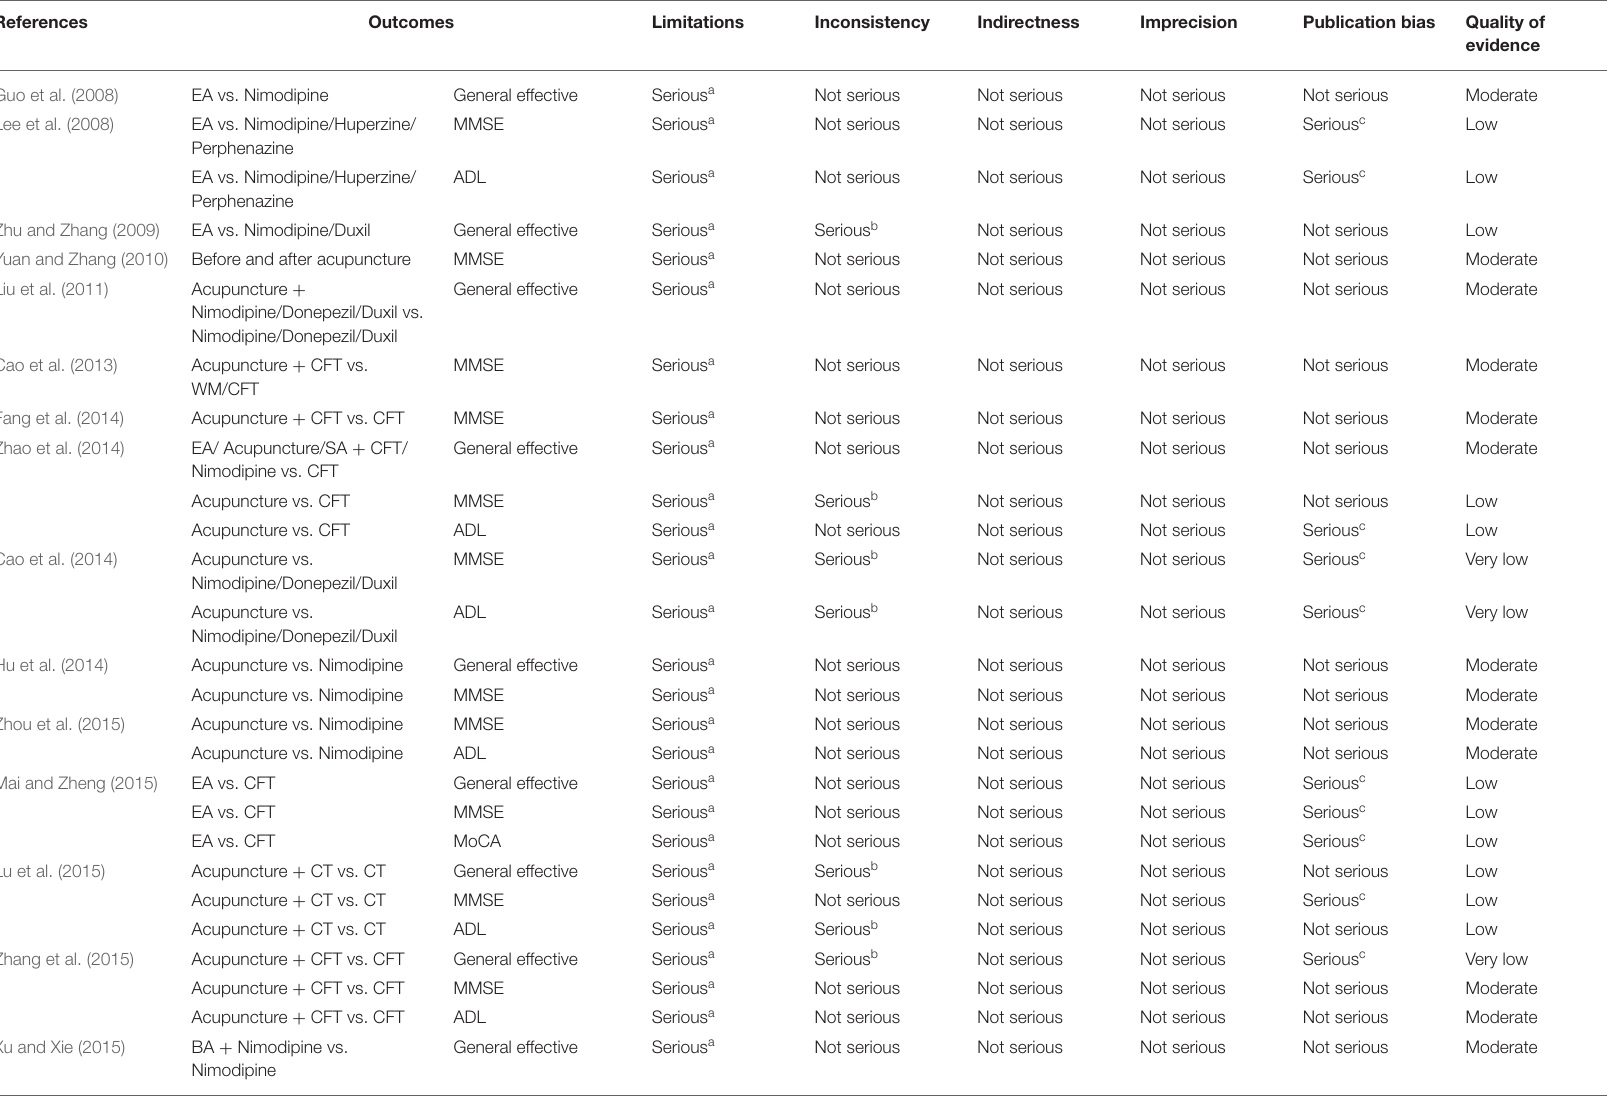
TABLE 3 | Quality of evidence in included systematic reviews and meta-analyses with Grading of Recommendations Assessment, Development, and